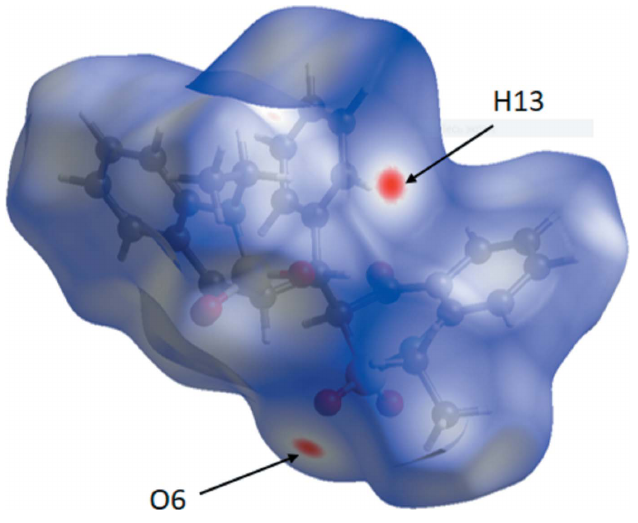
Figure 6 Aview of the Hirshfeld surface of a molecule of 7C( R , R , S ) mapped over d norm in the range (cid:4) 0.129 to 1.589 a.u.